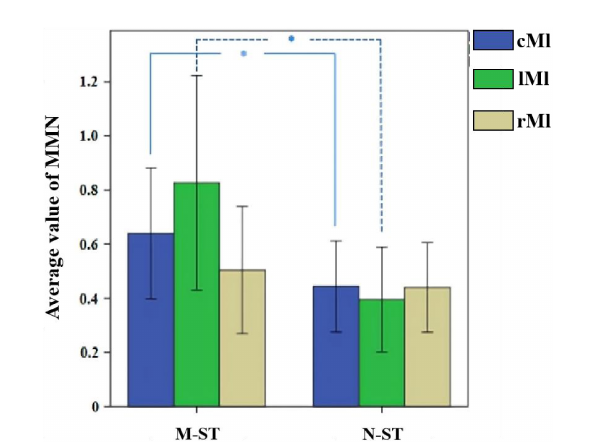
FIGURE5 Mean MMN value across all 18 subjects and the results of statistical analysis. ∗ Refers to p < 0.05 with one-way ANOVA. In the M-ST task, the MMN from the frontal parietal motor sensory cortex and the left motor cortex was significantly